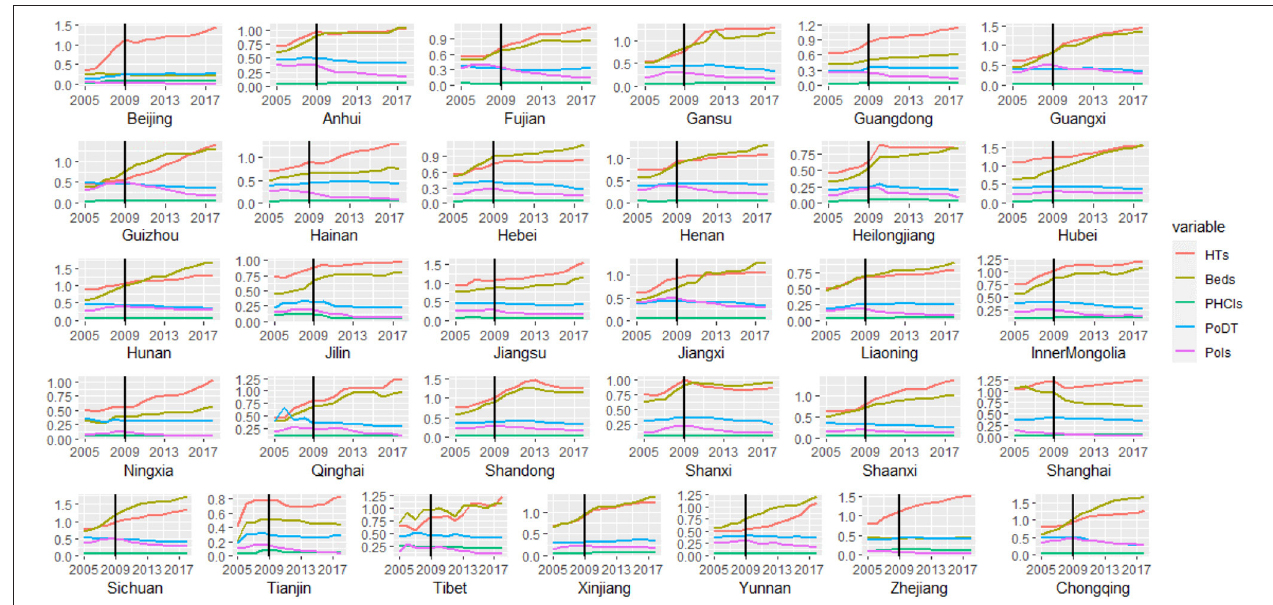
FIGURE 1 | Changes in input and output of China’s provinces in